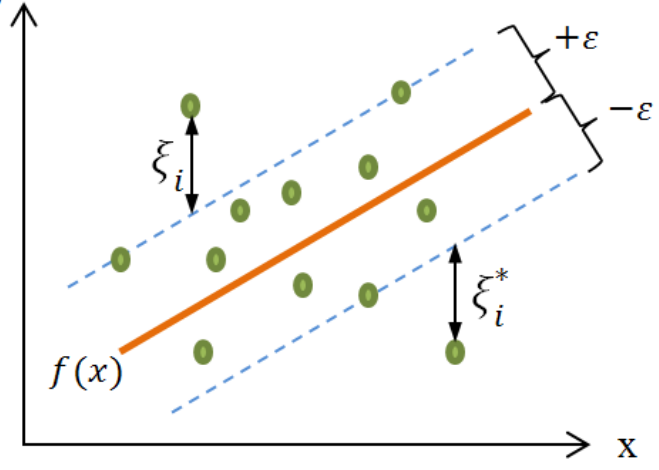
Figure 2. The principle of the SVR in two